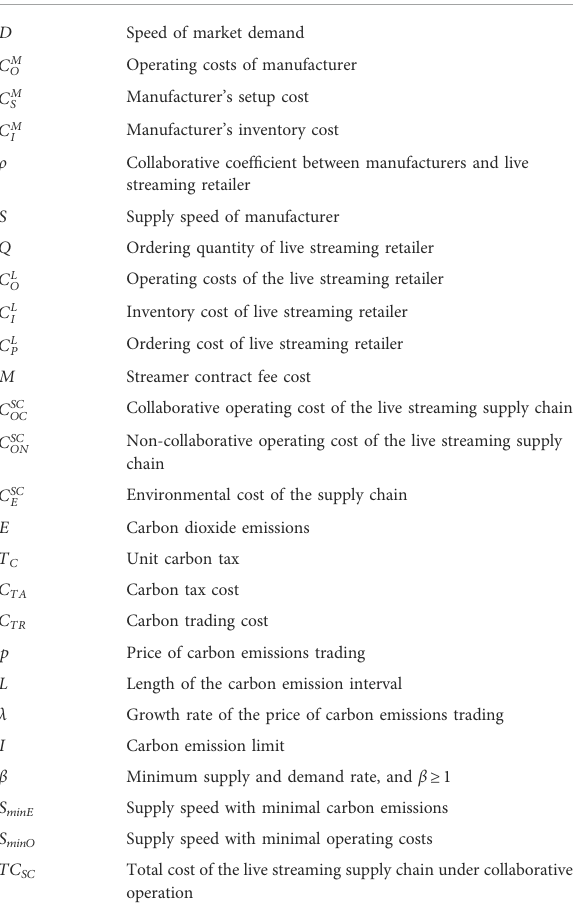
TABLE 1 De fi nition of parameters and